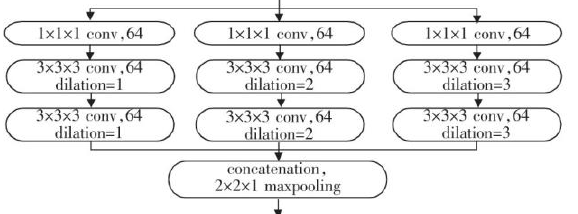
Figure 4. Shallow multi-scale module